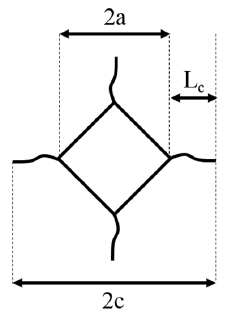
Figure 3. Diagonal and crack lengths of a Vickers indentation.